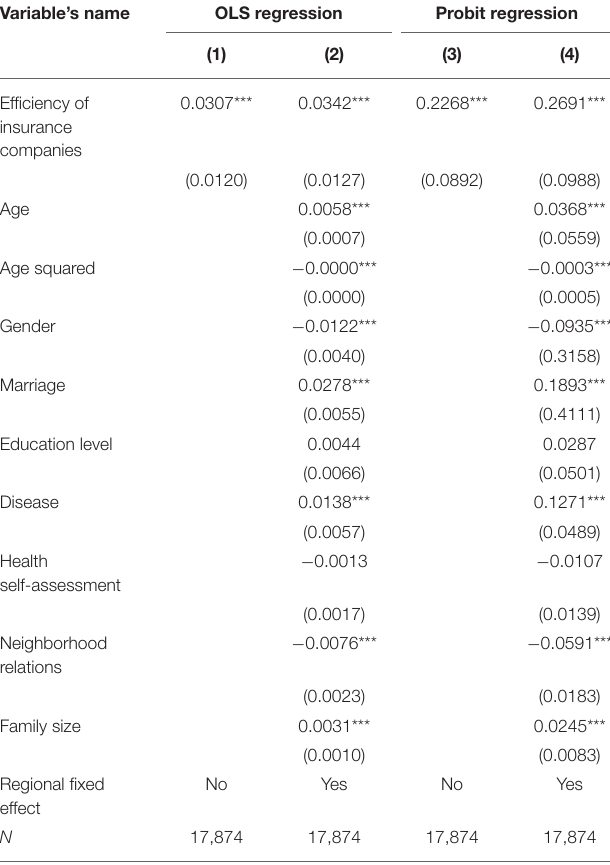
TABLE 3 | Comprehensive scale technical efficiency value of insurance company. TABLE 4 | Basic regression